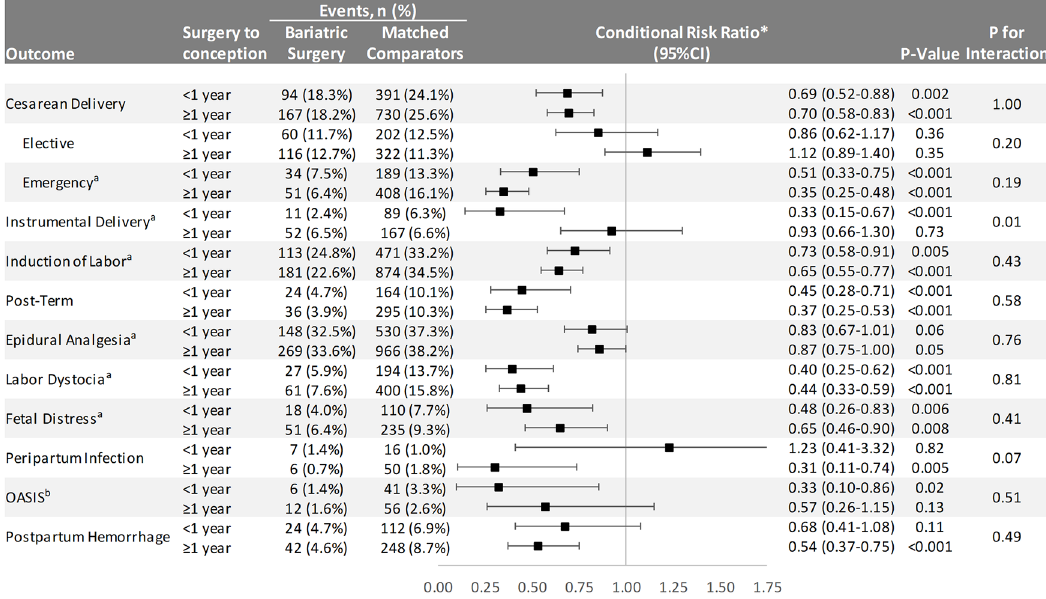
Fig 5. Delivery outcomes in singleton live term births in Swedish women between 2006 and 2013 stratified by surgery-to- conception interval. OASIS = obstetric anal sphincter injury (perineal tear grade III–IV). Emergency cesarean delivery = all unplanned cesarean sections. a Elective cesarean deliveries excluded. b Cesarean deliveries excluded. (cid:3) Conditioned on the matching factors maternal age, parity, pre-surgery BMI category (using early-pregnancy BMI in controls), early-pregnancy smoking status, educational level, height, country of birth, and delivery